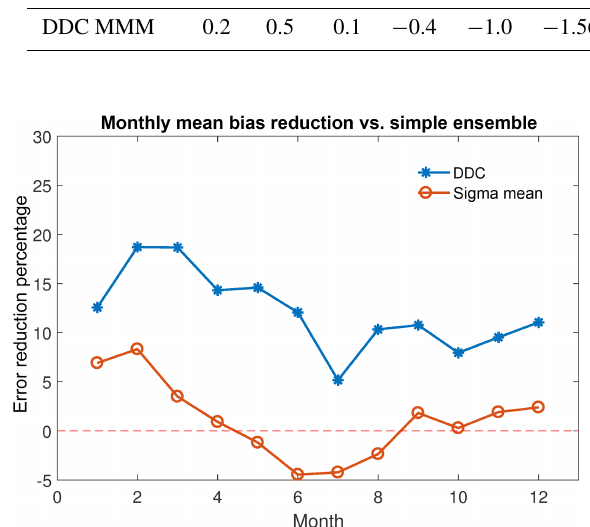
Figure 2. Temporal variability in global mean (tropospheric col- umn ozone) absolute bias reduction (%, MMM ozone − observed ozone) with respect to simple arithmetic MMM. Blue points denote bias reduction using DDC clustering to determine model inclusion into the MMM. Orange points denote bias reduction using just the model spread (1 σ ) to determine model inclusion into the MMM (i.e. without